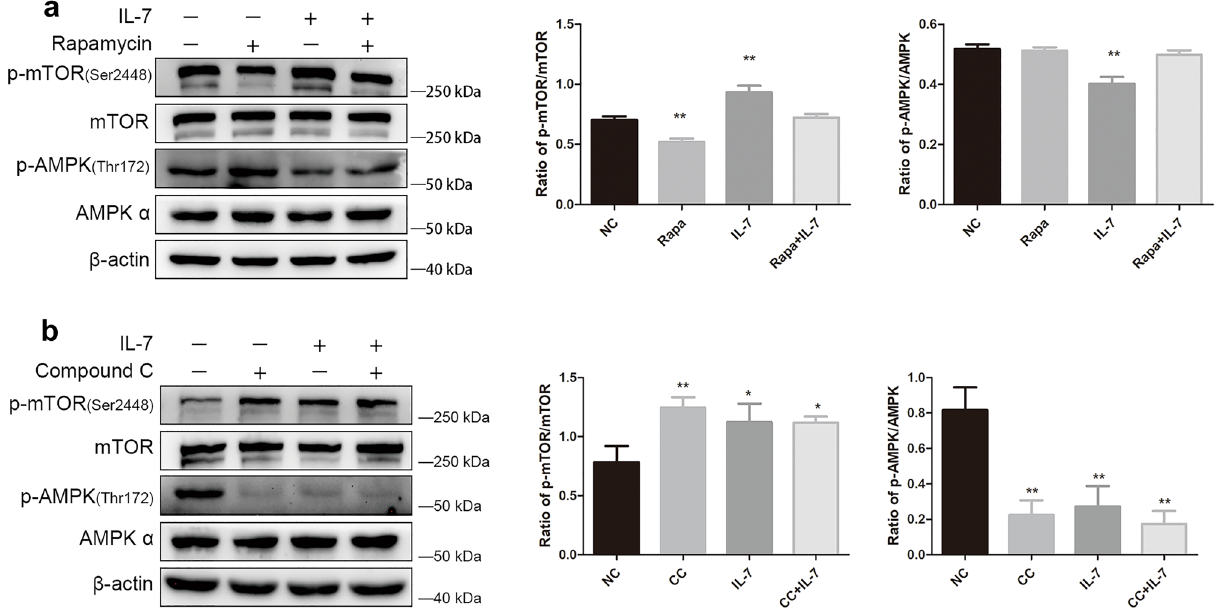
Figure 3. IL-7 regulate mTOR via AMPK. ( a ) Rapamycin manipulate the down-regulation of p-mTOR/mTOR but had no effect on p-AMPK/AMPK. Besides, Rapamycin impede IL-7 regulated p-mTOR up-regulation. ( b ) Compound C down-regulate the p-AMPK/AMPK expression meanwhile escalate p-mTOR/mTOR expression. IL-7 and Compound C had similar effect on A549 cell. The bar graph corresponding to their western blot results show different kind of protein analysis after cell treated with IL-7, Rapamycin IL-7 + Rapamycin, Cpmpound C and IL-7 + Compound C, then compared with negative control. Mean ± SD, n = 3. *represent for P < 0.05. ** and *** represent for P < 0.01 versus